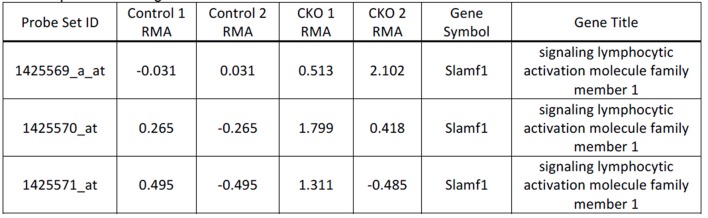
DOI:
http://dx.doi.org/10.7554/eLife.07539.014